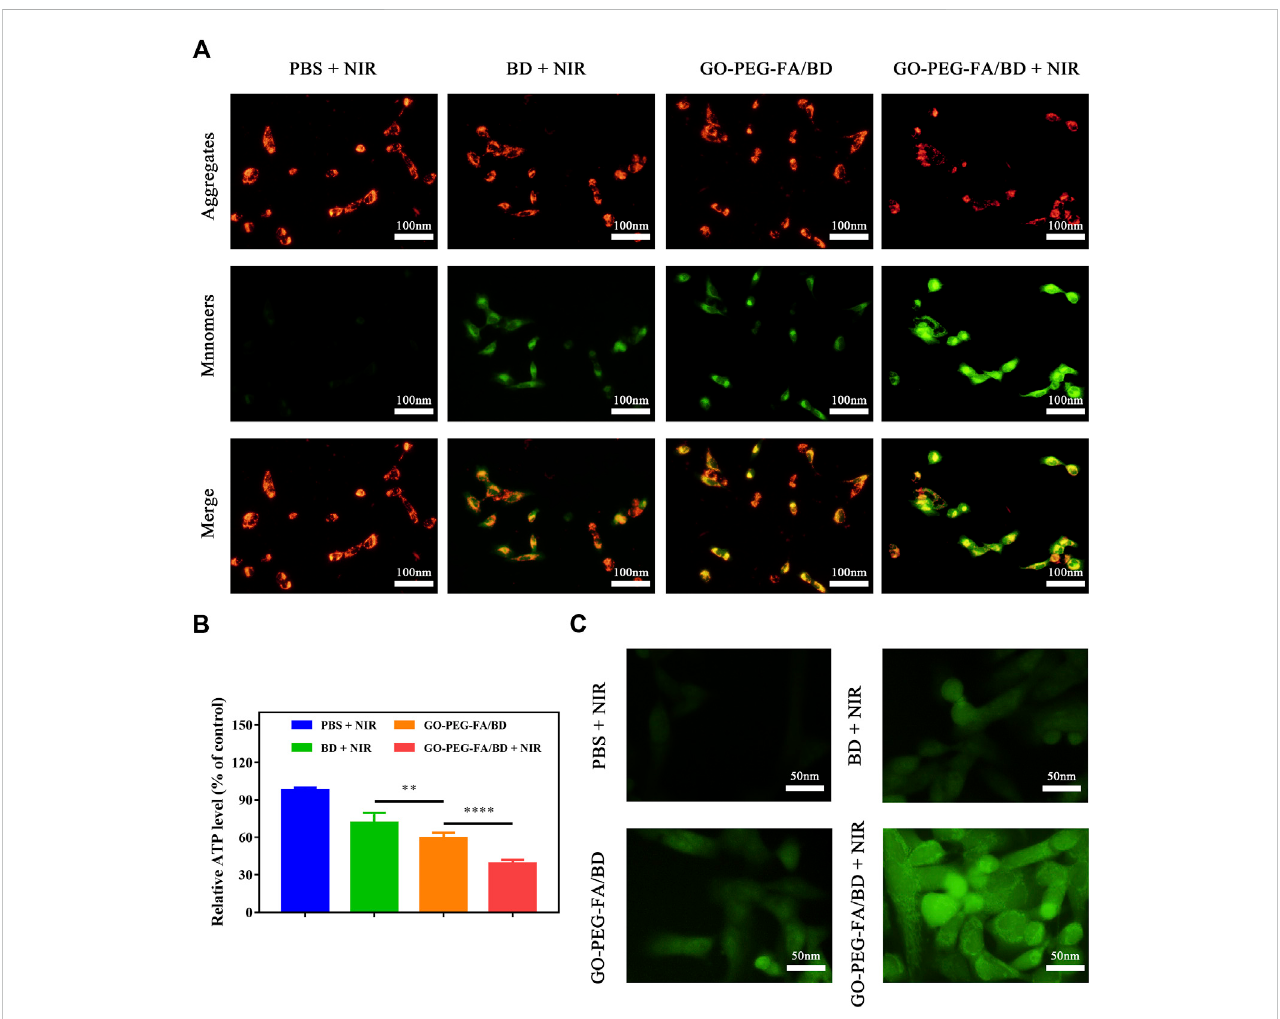
FIGURE 3 (A) Variation of the membrane potential of mitochondria after different treatments. (B) Relative ATP level of MNNG/HOS cells after corresponding treatments. (C) ROS generation of MNNG/HOS cells after various